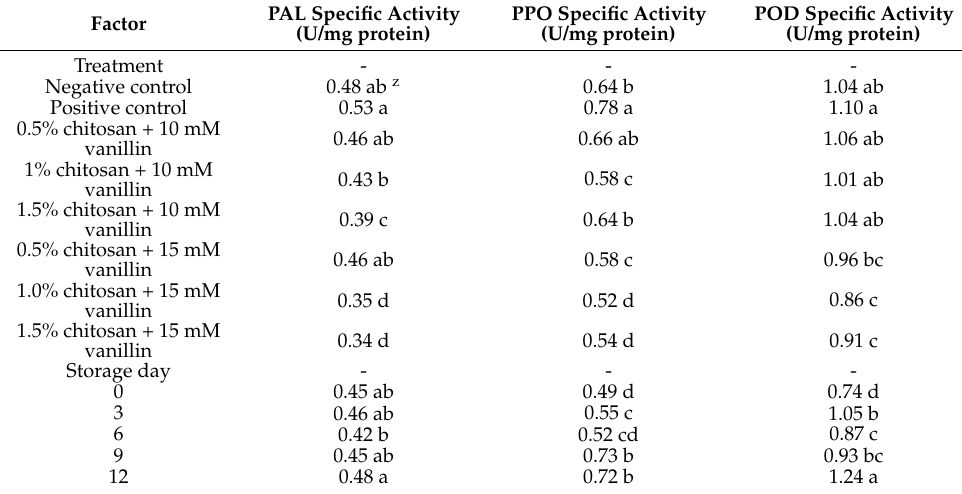
Table 6. Main and interaction effects of different coating treatments and storage days on